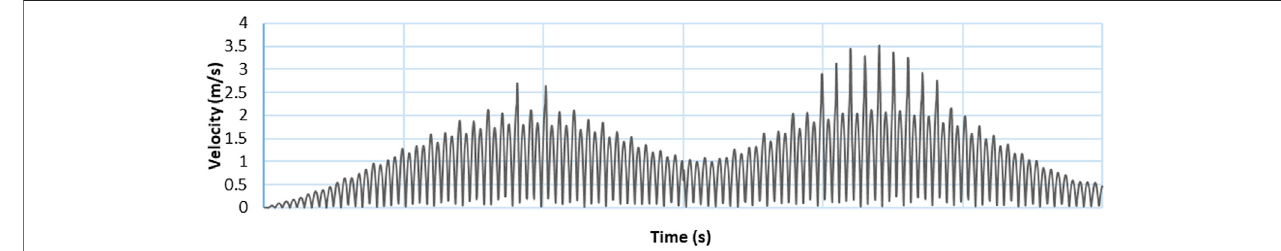
FIGURE 4 | Velocity pro fi le of alderney race with the friction coef fi cient of 0.0025.